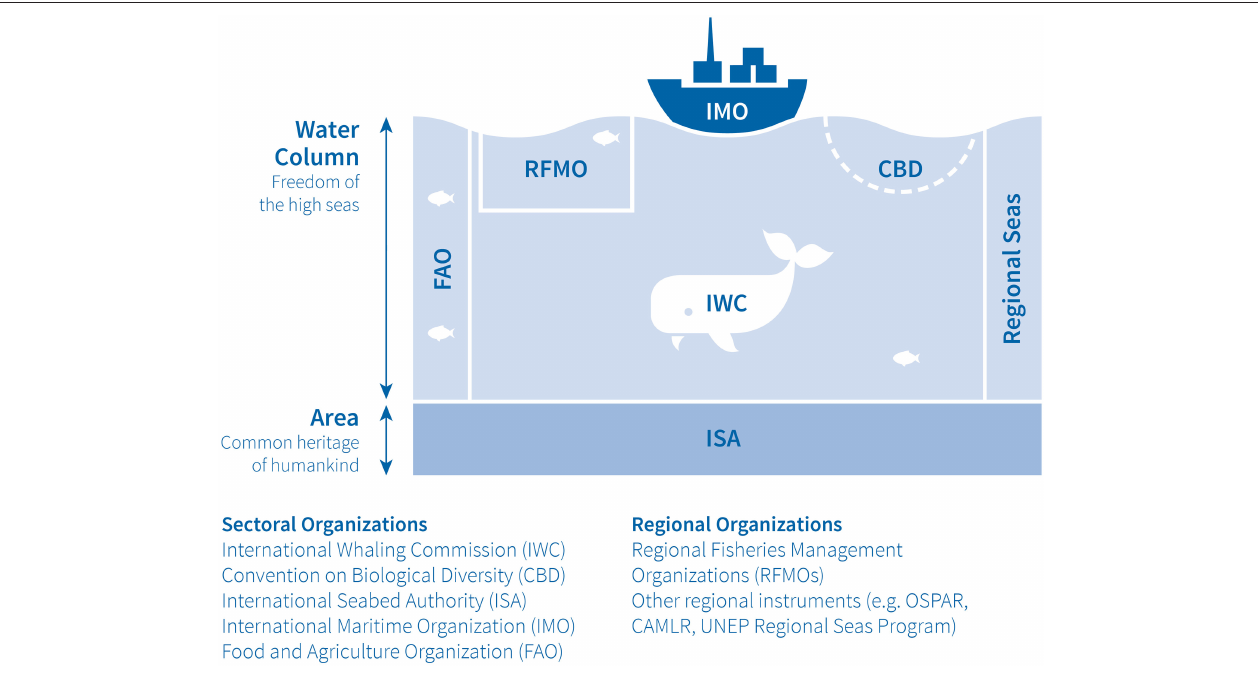
FIGURE 1 | Patchwork of sectoral and regional organizations in